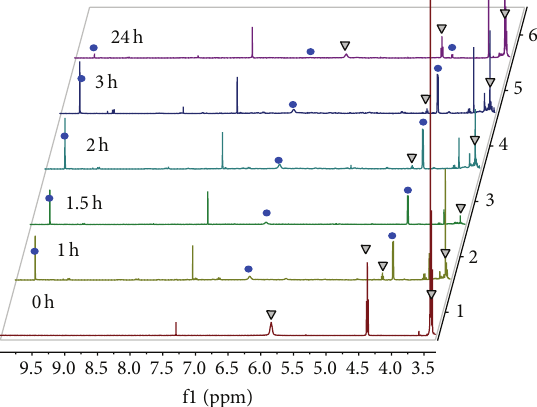
Figure 1: 1 H NMR spectra in CDCl 3 of the crude reaction of 3 with Bi(NO 3 ) 3 at different reaction times. The triangles indicate the signals associated with compound 3 , and the circles indicate the corresponding aldehyde